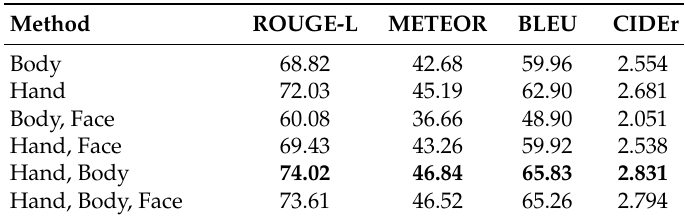
Table 10. Ablation study on the contributions of keypoints from body, face, and hands. The results are obtained on the test